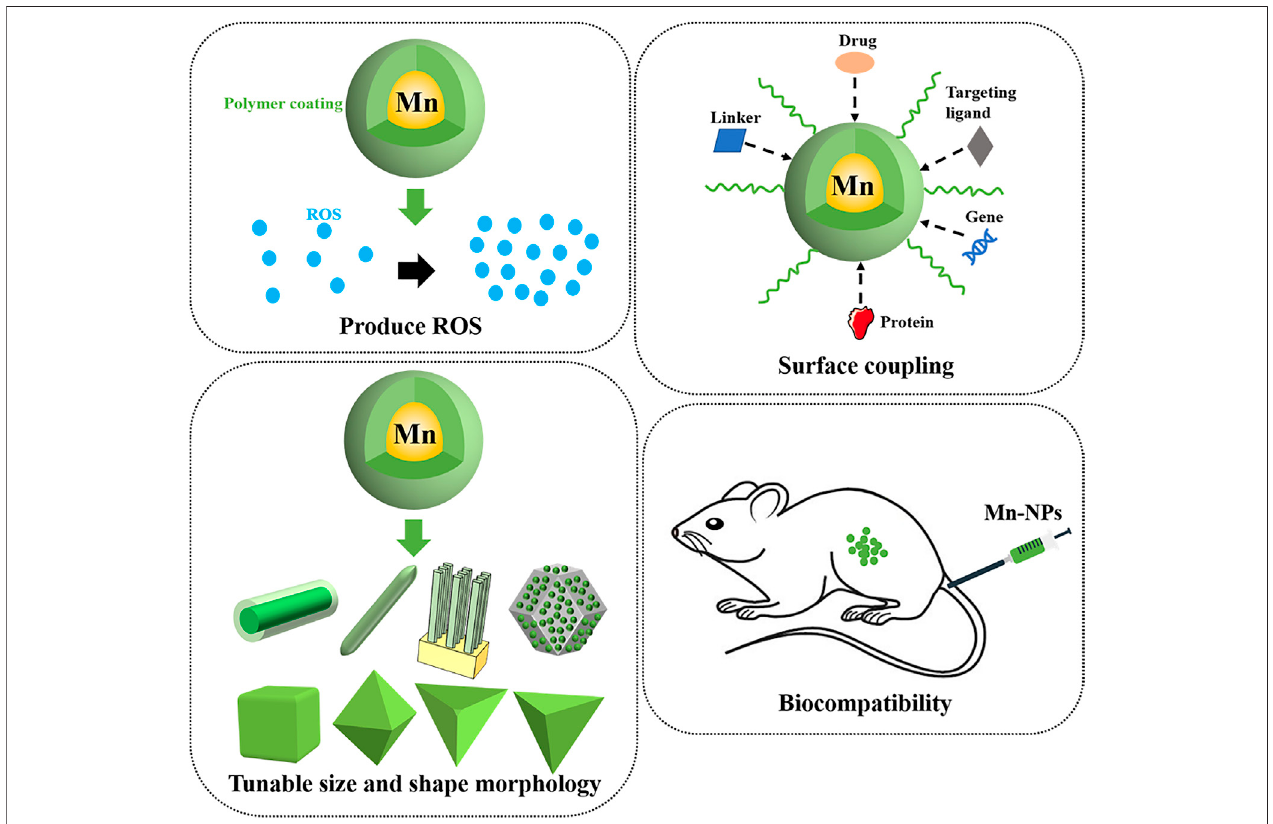
FIGURE 2 | Important properties of